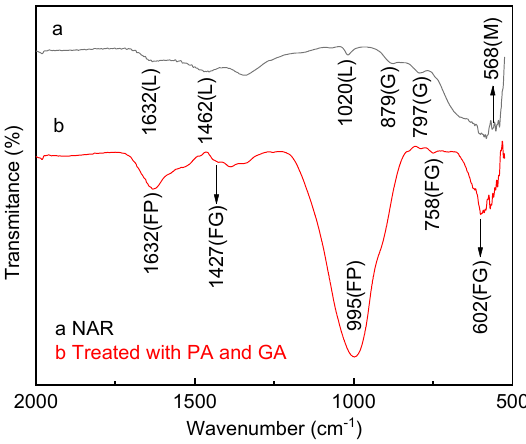
Figure 3. FTIR spectra of ( a ) NAR, ( b ) Treated with PA and GA (L: lepidocrocite, G: goethite, M: magnetite, FP: ferric phosphate, FG: ferric gallate).